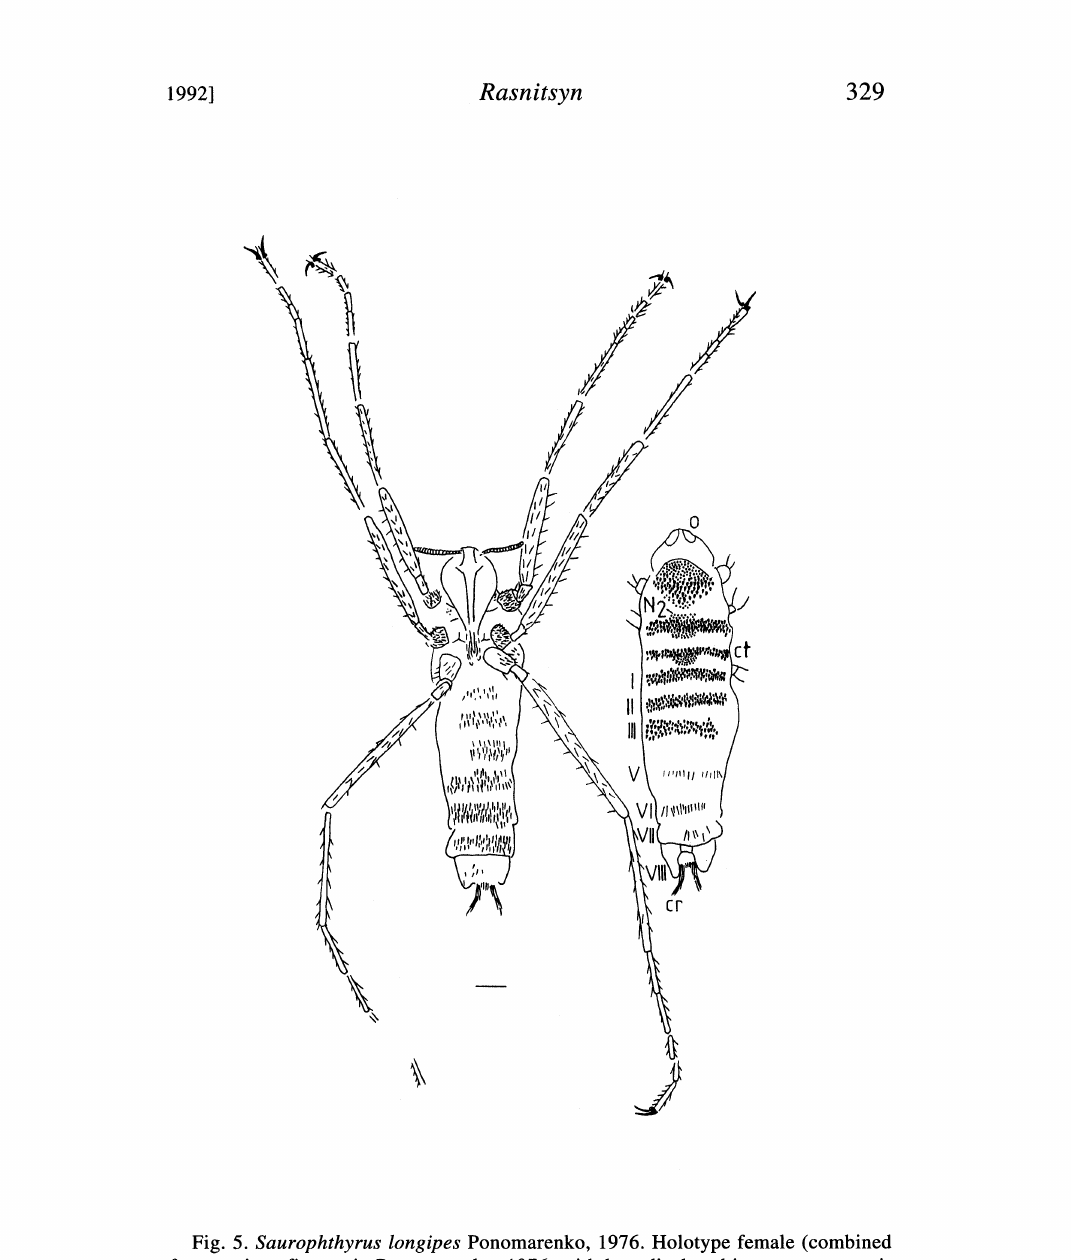
Fig. 5. Saurophthyrus longipes Ponomarenko, 1976. Holotype female (combined from various figures in Ponomarenko, 1976, with legs displaced in more symmetri- cal position). Ventral and, for the body alone, dorsal view. Scale bar, mm. Abbre- viations: or-cercal brush, ct ctenidium, o eye, others as on previous